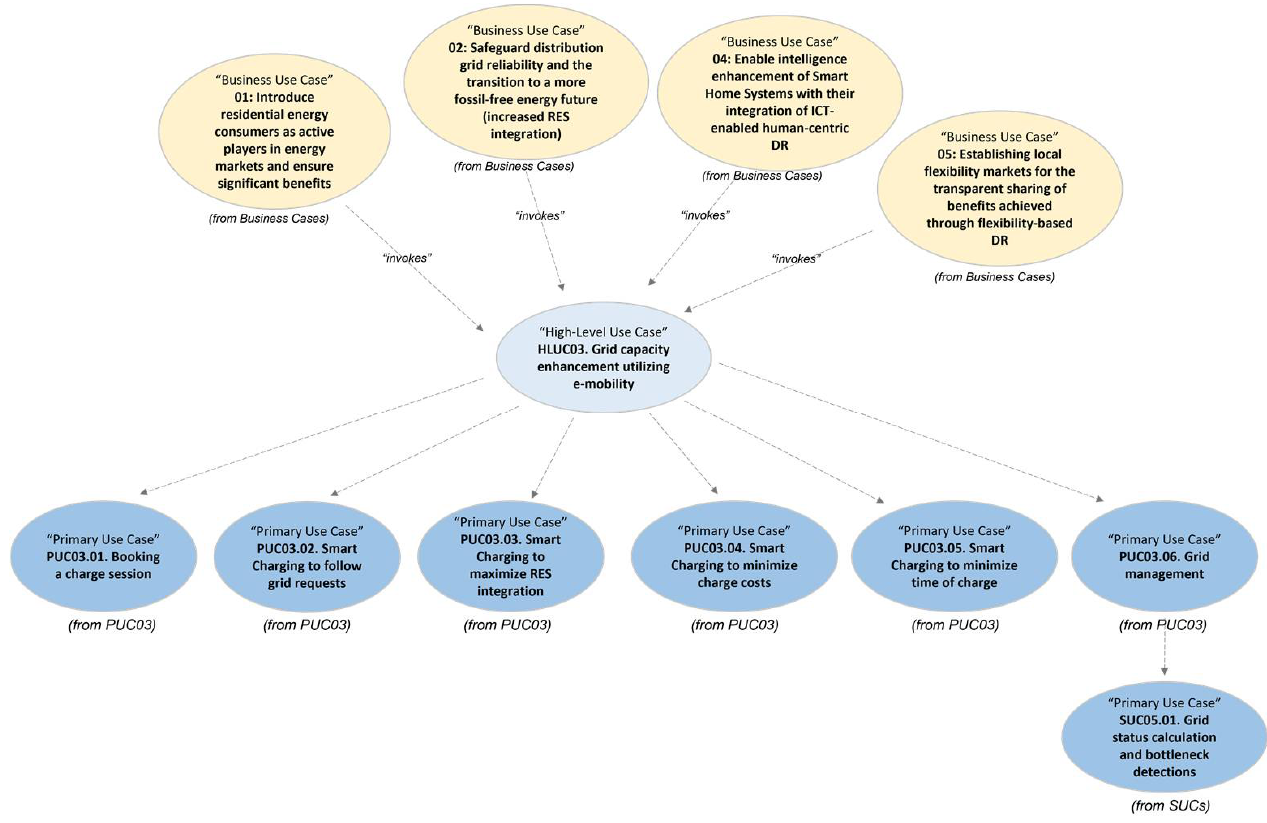
Figure 4. SGAM Business layer of the HLUC.